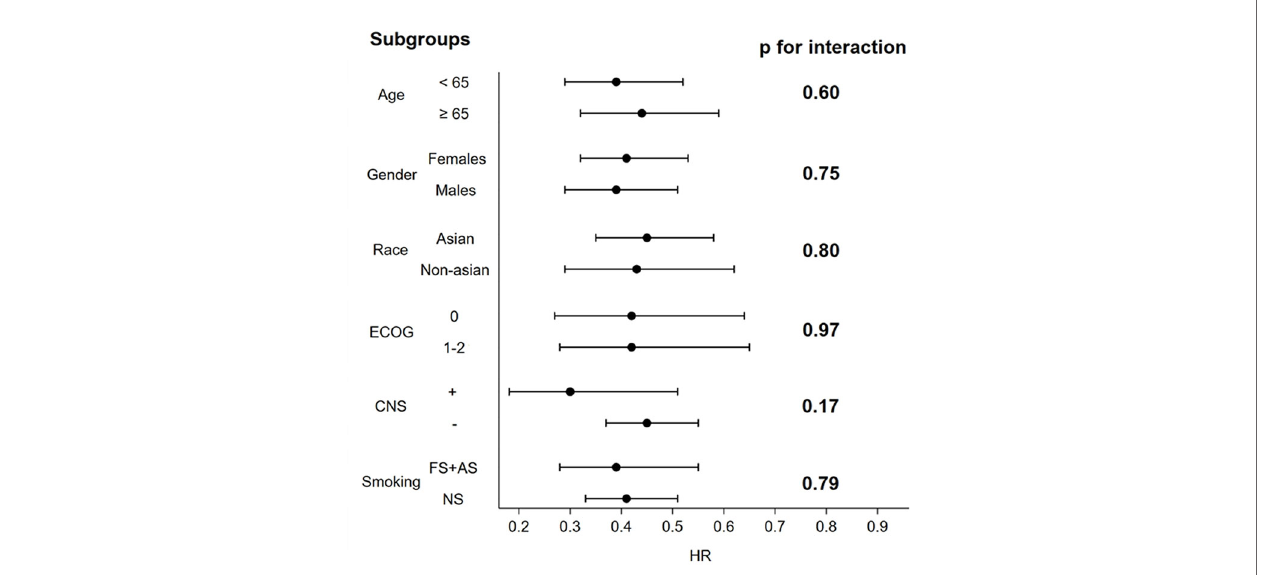
FIGURE 3 | Forest plots of HR associated with next-generation ALKIs compared to control therapies for prespeci fi ed PFS subgroups